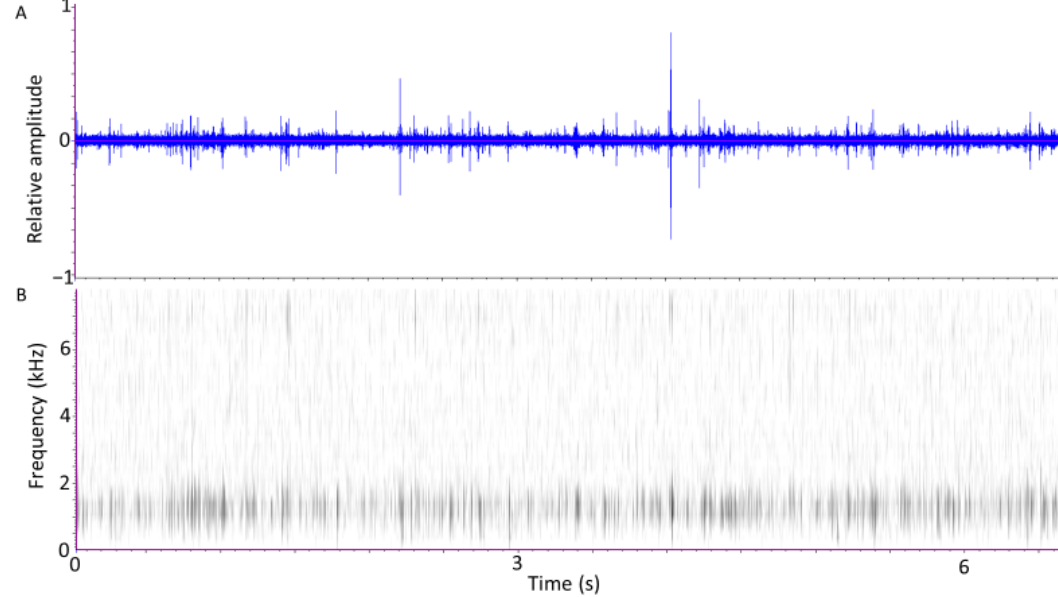
Figure 1. ( A ) Oscillogram and ( B ) Spectrogram of a 6.7 s interval of sounds recorded from 10 adult S. oryzae . Darker areas in the spectrogram (calculated at 128 points/spectrum) indicate greater energy at specific frequencies and times.